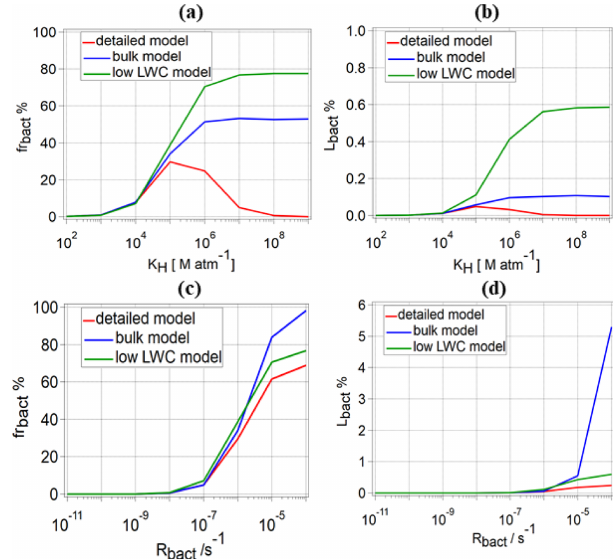
Figure 9. Comparison of (a) fr bact and (b) L bact for water-soluble organic gases for three different model approaches: detailed model (red line), bulk approach (blue line), and low-LWC model (green line) for different values of K H , R chemaq = 10 − 7 s − 1 , R bact . = 10 − 6 s − 1 , and R chemgas = 10 − 6 s − 1 ; (c) fr bact and (d) L bact for water-soluble organic gases for the same approaches for different R bact , one value for K H = 10 5 Matm − 1 , two values for R chemaq (10 − 7 s − 1 , 10 − 11 s − 1 ), and R chemgas = 10 − 6 s − 1 .